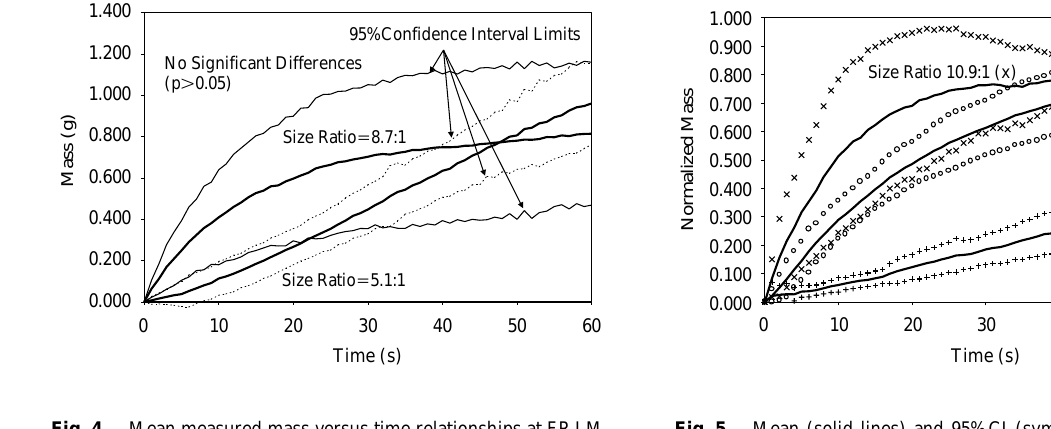
Fig. 4 Mean measured mass versus time relationships at FR-LM and 95% confidence intervals